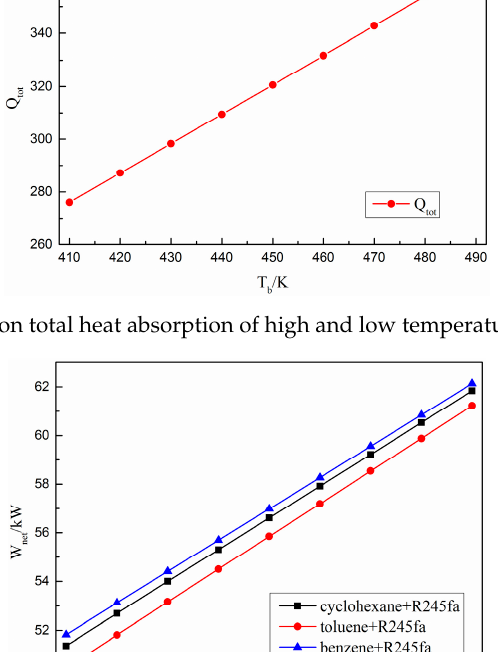
Figure 9. Effect of T b on the net output power of the cycle.